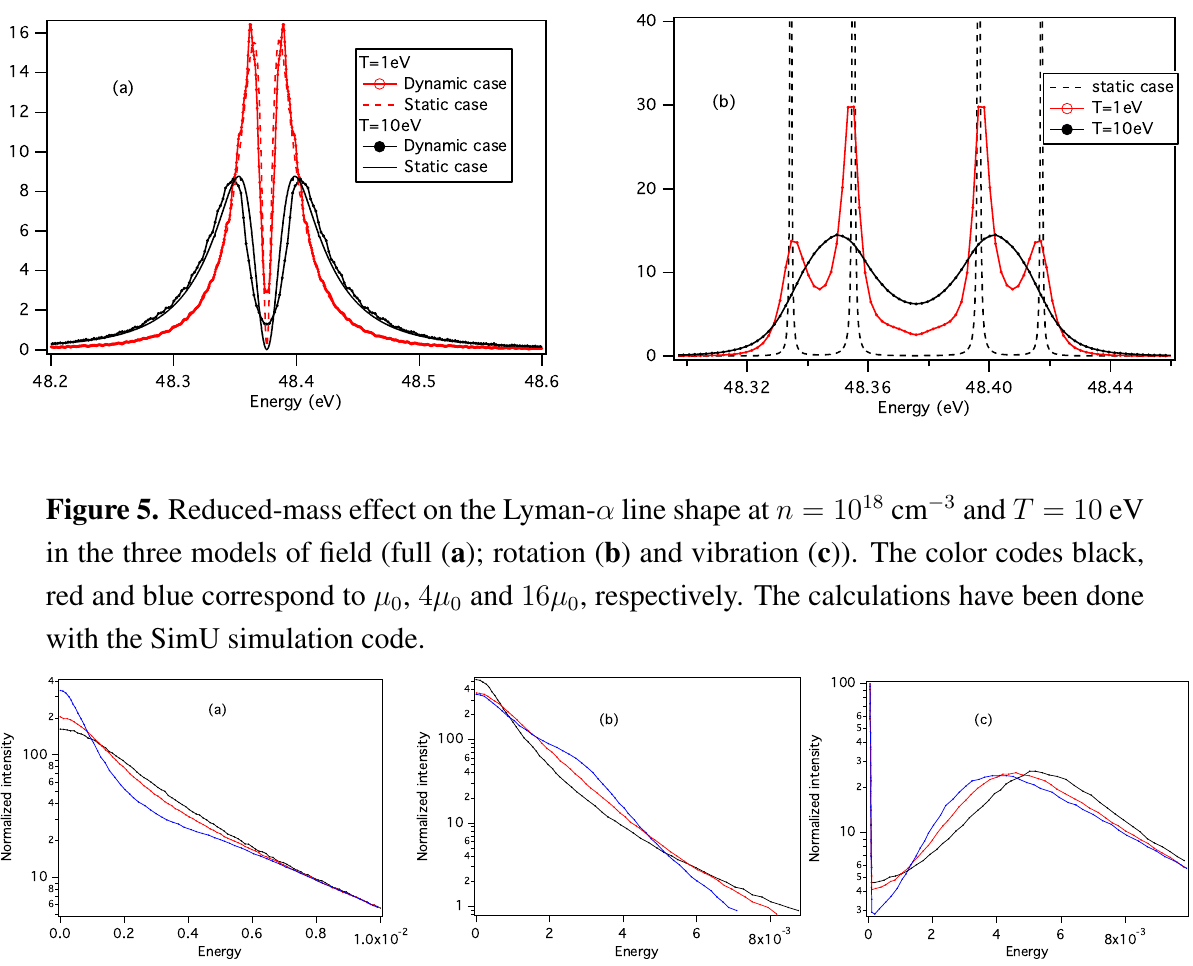
Figure 4. Spectral line shapes of the Lyman- β line in a pure vibrating field ( a ) and a pure rotating field ( b ) compared to the corresponding static profiles, at n = 1 × 10 19 cm − 3 and two temperatures, T = 1 and T = 10 eV. The dynamic case results have been obtained with the BinGo simulation code.